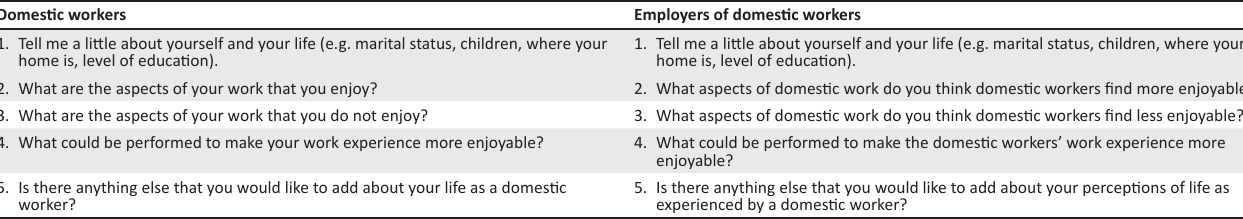
TABLE 3: Interview questions for domestic workers and employers. Domestic